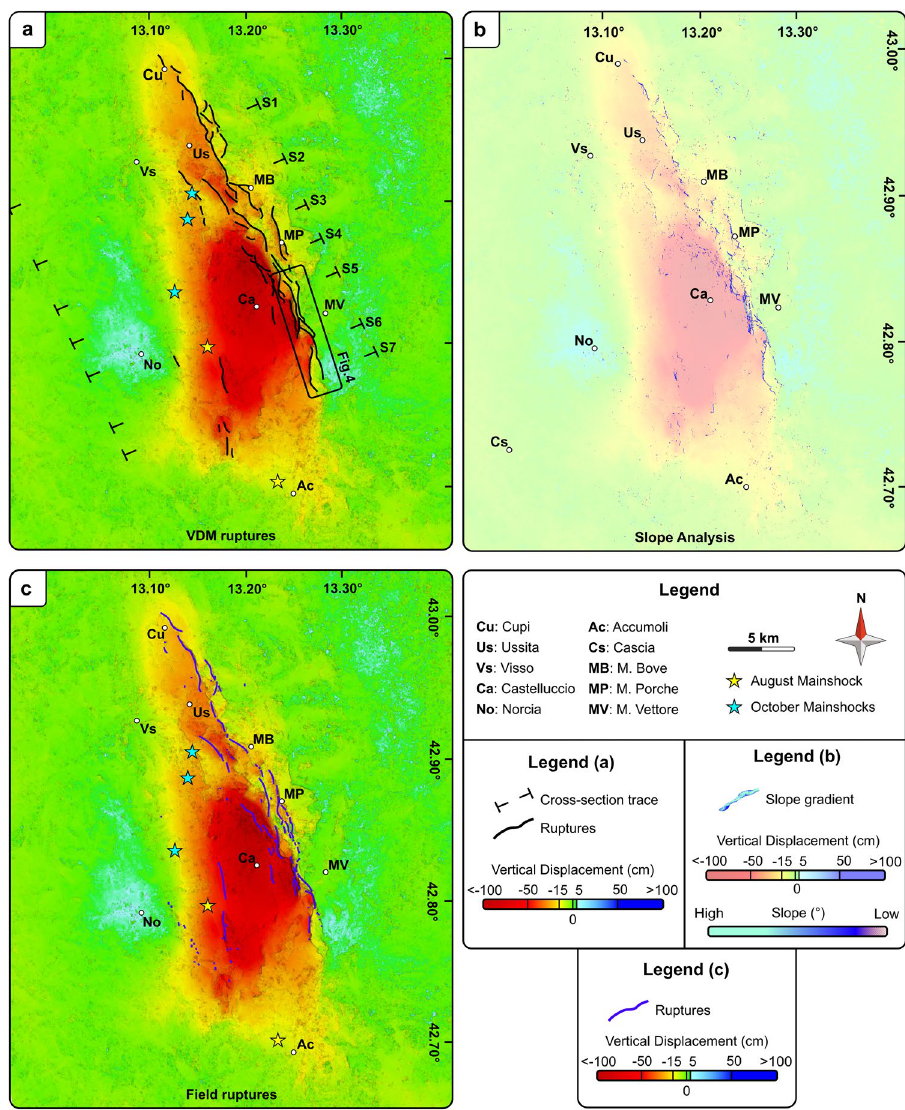
Figure 2. Comparison between DInSAR and field data. ( a ) Vertical displacement map (VDM1) with traces of the coseismic surface ruptures from this study and the cross-section traces (labelled S1 to S7). ( b ) Results of the slope analysis carried out on the whole studied area and superimposed on the VDM1. The blue zones correspond to steep vertical gradients of the VDM1 and are interpreted as coseismic ruptures. ( c ) Vertical displacement map (VDM1) with traces of the coseismic surface ruptures from the field surveys 8 (purple